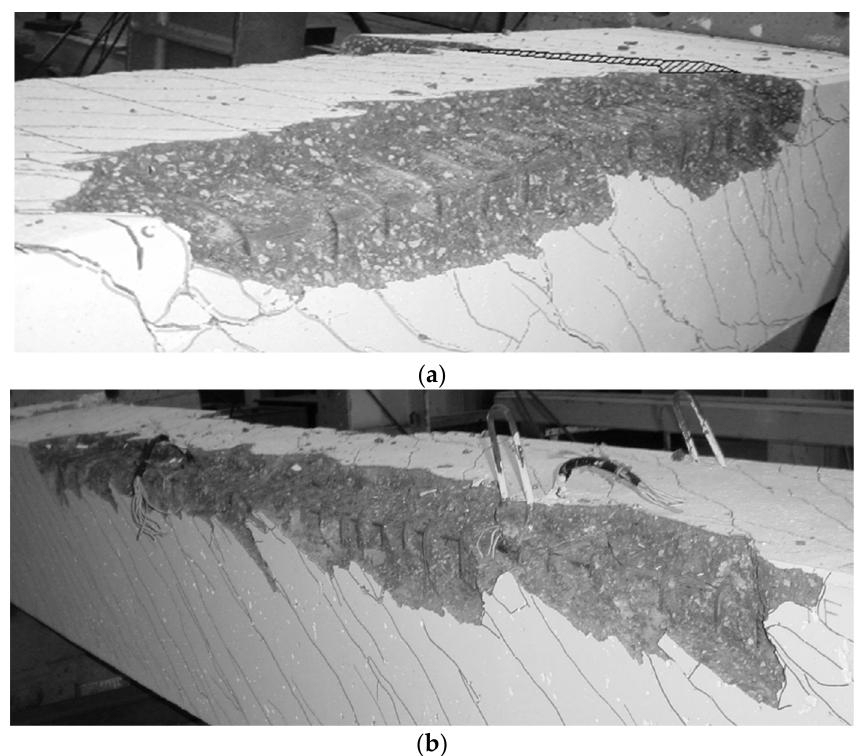
Figure 10. Fragile failure by concrete break off at the corners: ( a ) Beam D-0 and ( b ) Beam D-1.79.